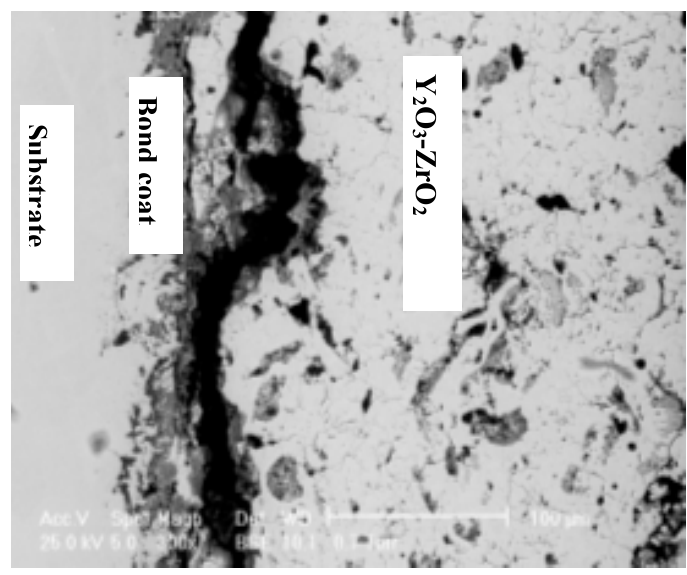
Figure 4. SEM image of the NiCoCrAlY bonding coat/Y 2 O 3 -ZrO 2 coating (reprinted from [69]).